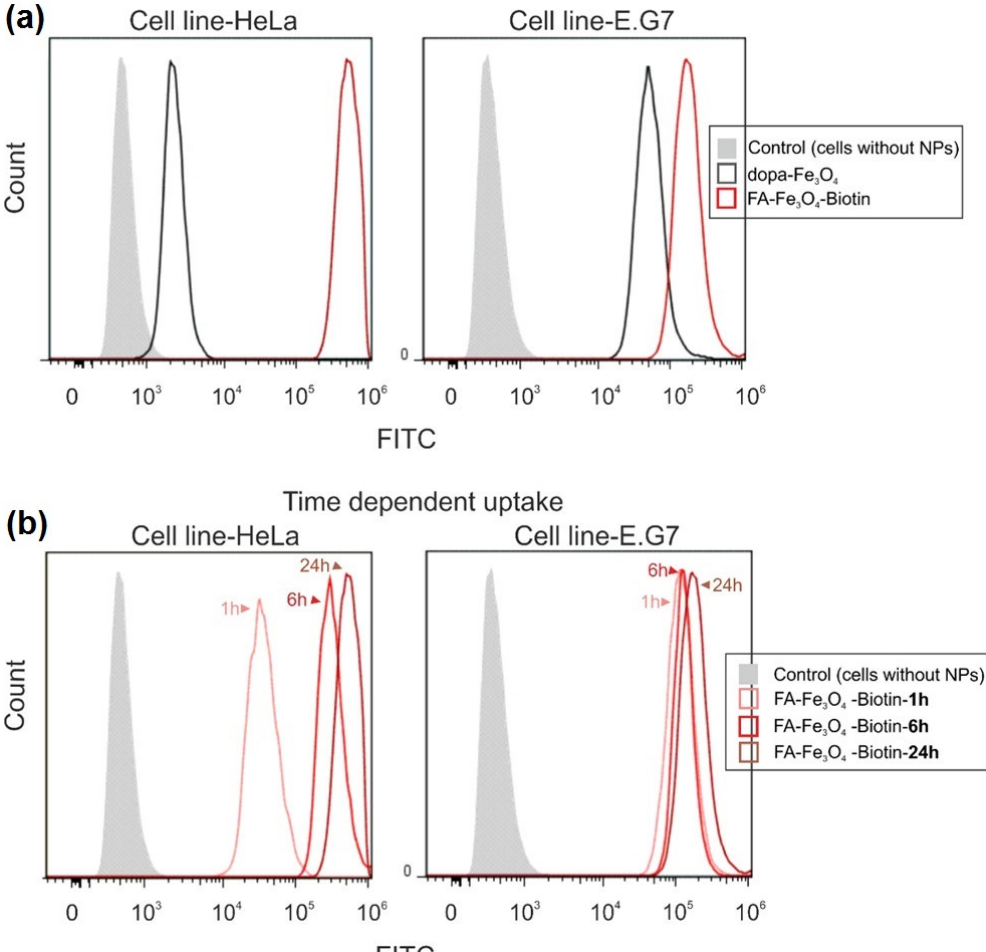
Figure 18. Flow cytometry plots showing the cellular uptake of ( a ) modified and unmodified Fe 3 O 4 nanoparticles and ( b ) modified nanoparticles over time in HeLa and E.G7 cancer cells. Reproduced with permission from reference [45]. Copyright 2020 American Chemical Society.